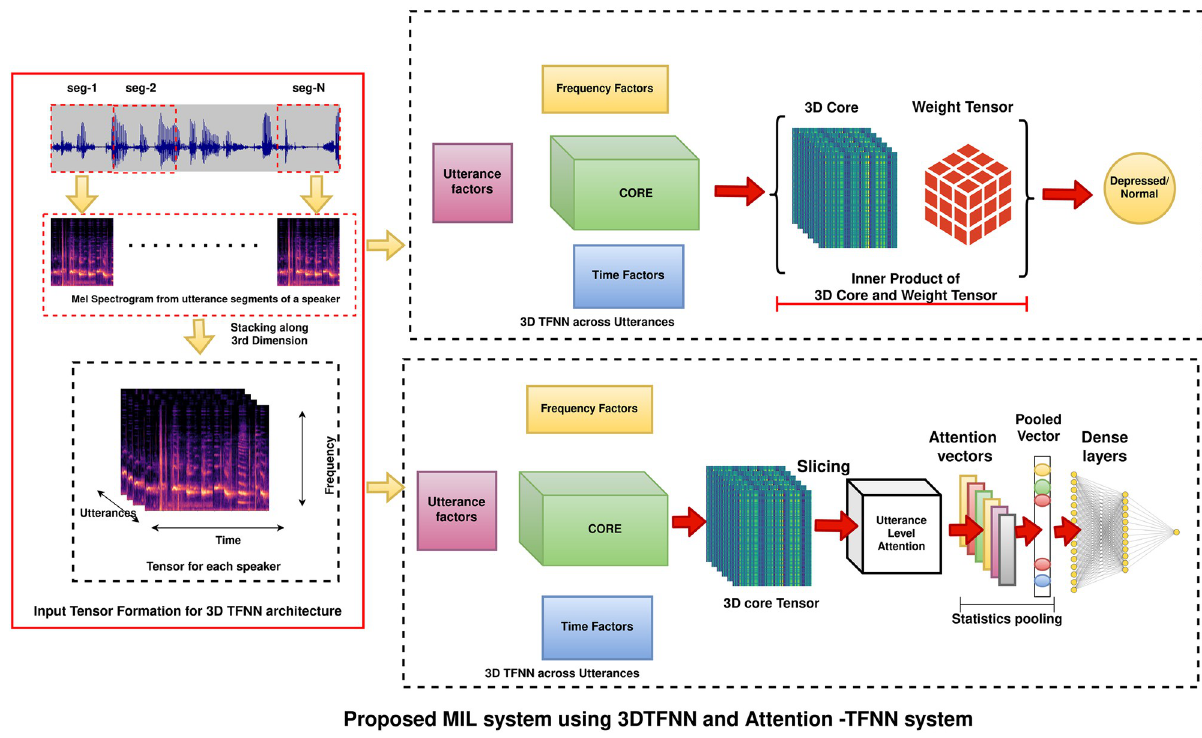
Fig 2. MIL technique using 3D TFNN and 3D TFNN + Utterance level attention as base architectures. The input to the architectures is Mel- spectrogram tensor, generated by stacking mel-spectrograms of utterances by a speaker along the third dimension. For the 3D TFNN, stacks of 3D Tensor FF Layer followed by a Tensor Sigmoid Layer is depicted. For the 3D TFNN + Utterance level attention, the stacks of 3D Tensor FF Layer is followed by an utterance level attention layer. A statistics pooling layer aggregates information from the attentive feature vectors of utterances followed by a dense layer for